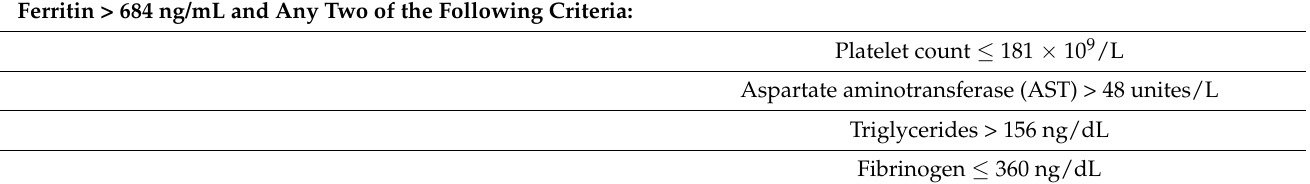
Table 3. Criteria for classification of MAS in patients with sJIA at the initiative of EULAR/ACR/ PRINTO collaborative